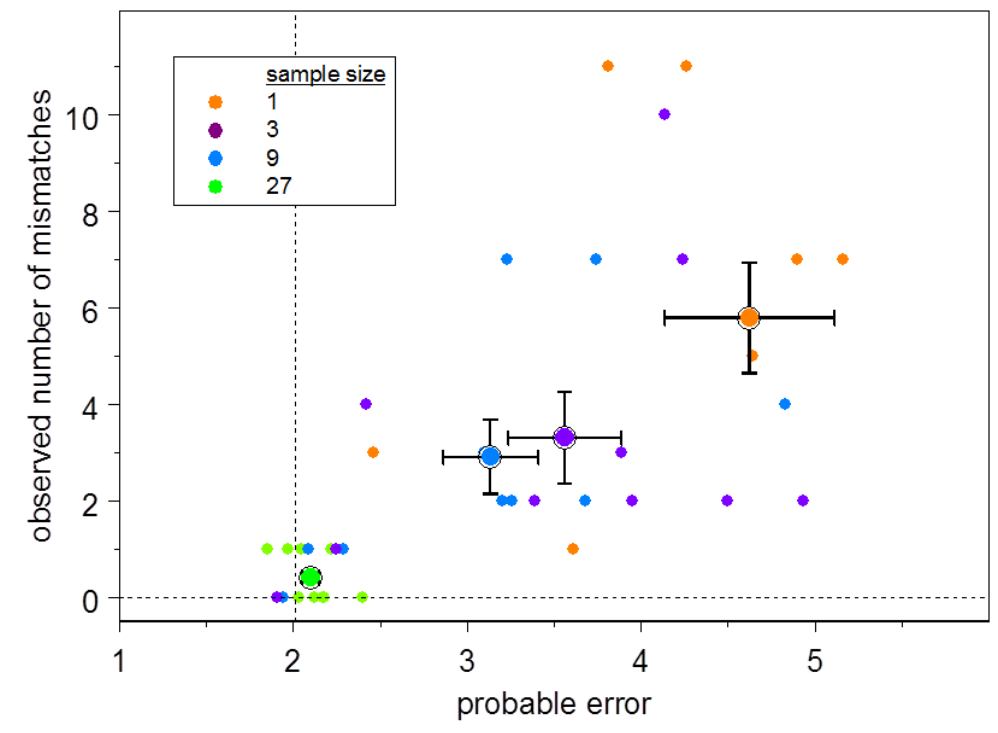
Figure 4. Observed number of mismatches vs. probable error. The number of mismatches between the modal unmutated ancestor (UA) for each subsample compared to the UA for the Clone H complete set vs. the estimated error summed over all positions for each Clone H subsample UA. Symbol color indicates subsample size as shown in the legend. The larger symbols indicate the means; the half-widths of the error bars are the standard errors of the means. The dashed vertical line indicates the total probable error using the complete 84-sequence